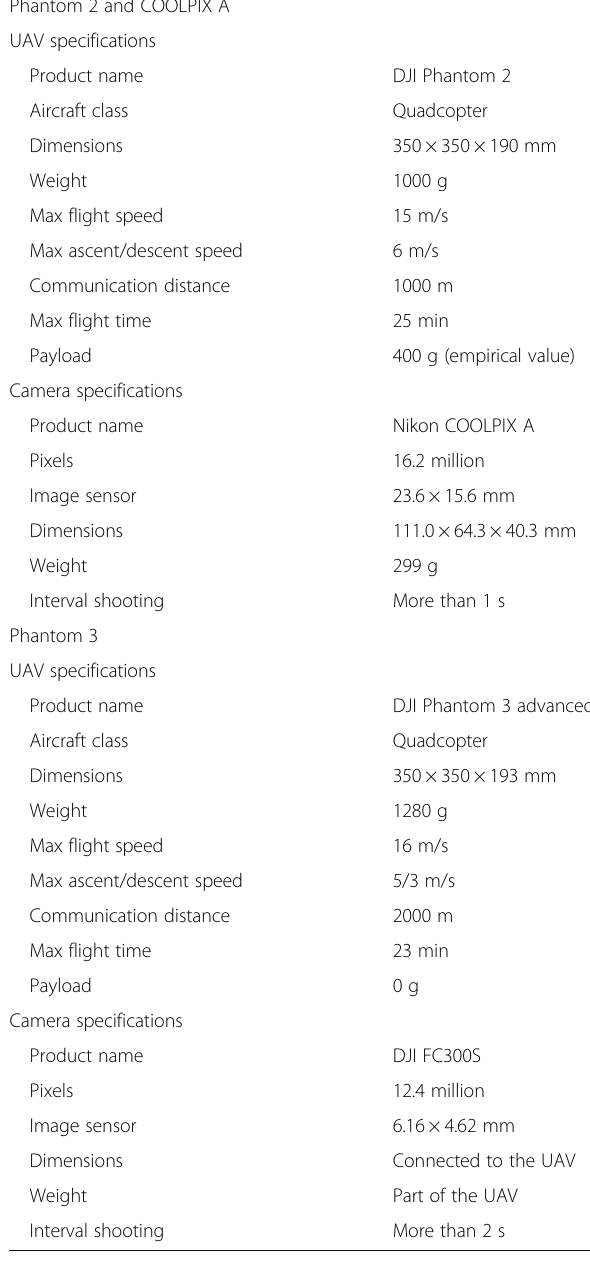
Table 1 Specifications of the UAVs Phantom 2 and COOLPIX